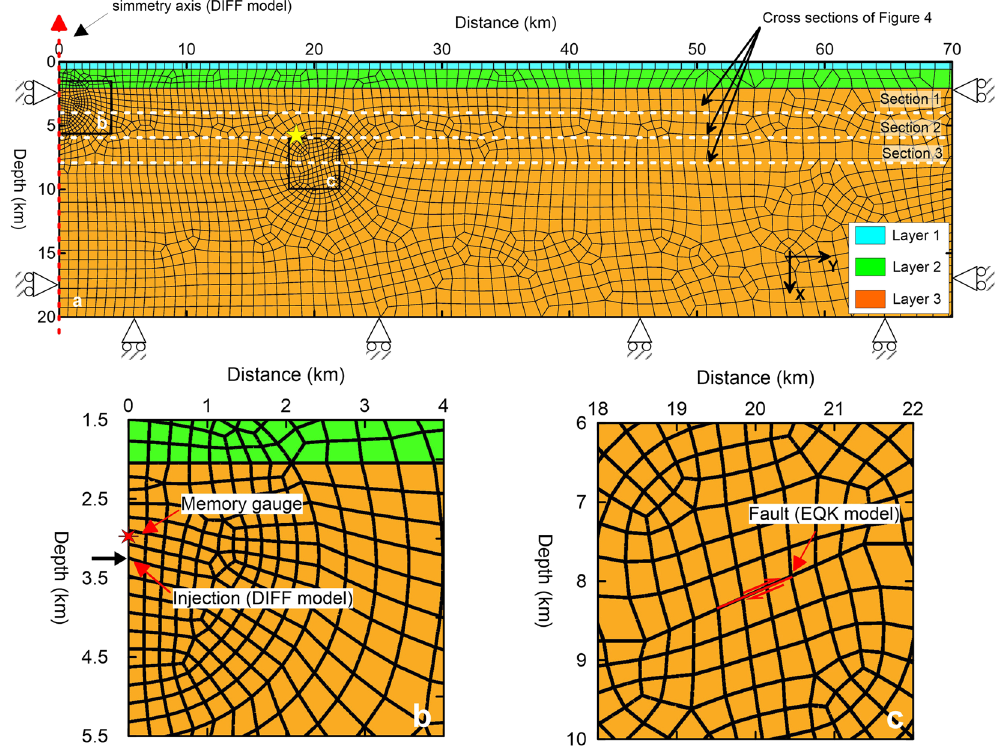
Figure 2. ( a ) Finite element geometry for the DIFF and EQK models. The yellow star identifies the May 20, 2012 earthquake hypocentre. The rollers constrain zero displacement normal to the boundary. The dashed red arrow identifies the symmetry axis of the DIFF model (corresponding to the Cavone 14 well). ( b ) Detailed illustration of the injection area of the DIFF model with the position of the memory gauge 43 . ( c ) Detailed illustration of the fault plane for the simulation of the Mw 4.5 earthquake. These figures were created with Surfer ® from Golden Software, LLC (www.goldensoftware.com).